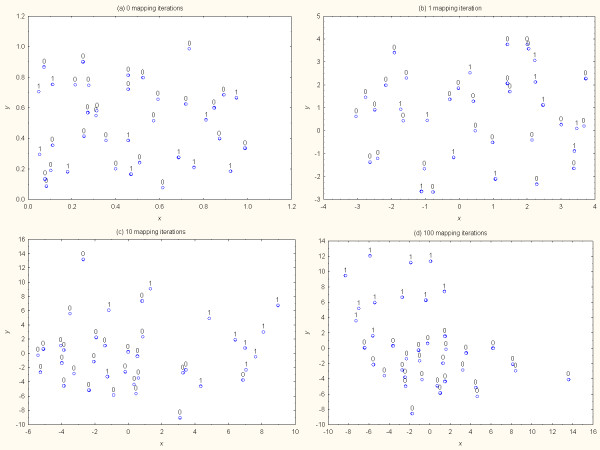
Visualisation of clusters in leukaemia data for different numbers of mapping iterations. Panels (a) to (d) show results for 0, 1, 10 and 100 mapping iterations respectively. Circles are used to represent the samples on the maps. Labels '0' and '1' refer to ALL and AML samples respectively.